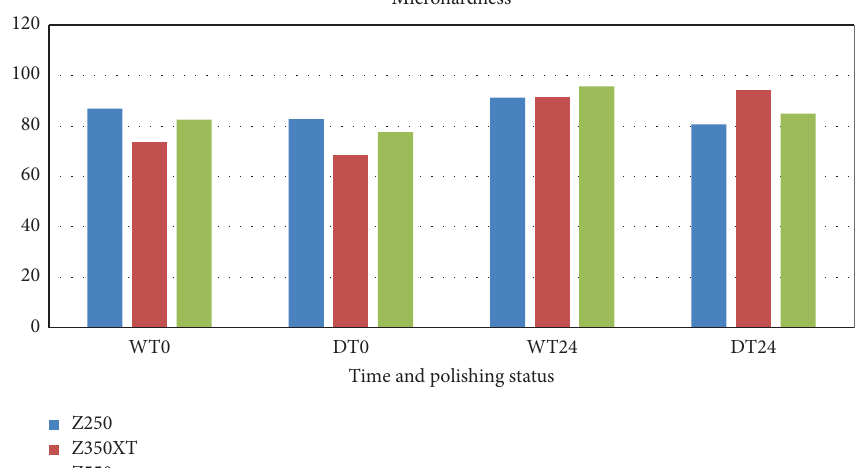
Figure 2: Te mean values of hardness for three diferent composites at immediately ( T